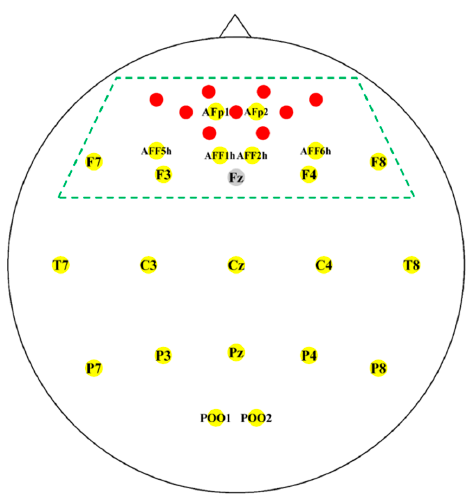
Figure 1. Placement of the EEG electrodes (yellow with labels) and the location of the NIRS channels (red). A ground electrode (gray) was located at Fz. An NIRS channel was created by a pair of neighboring source and detector optodes. Only EEG and NIRS channels within the (pre)frontal area denoted by the green dashed line were used for the data analysis.